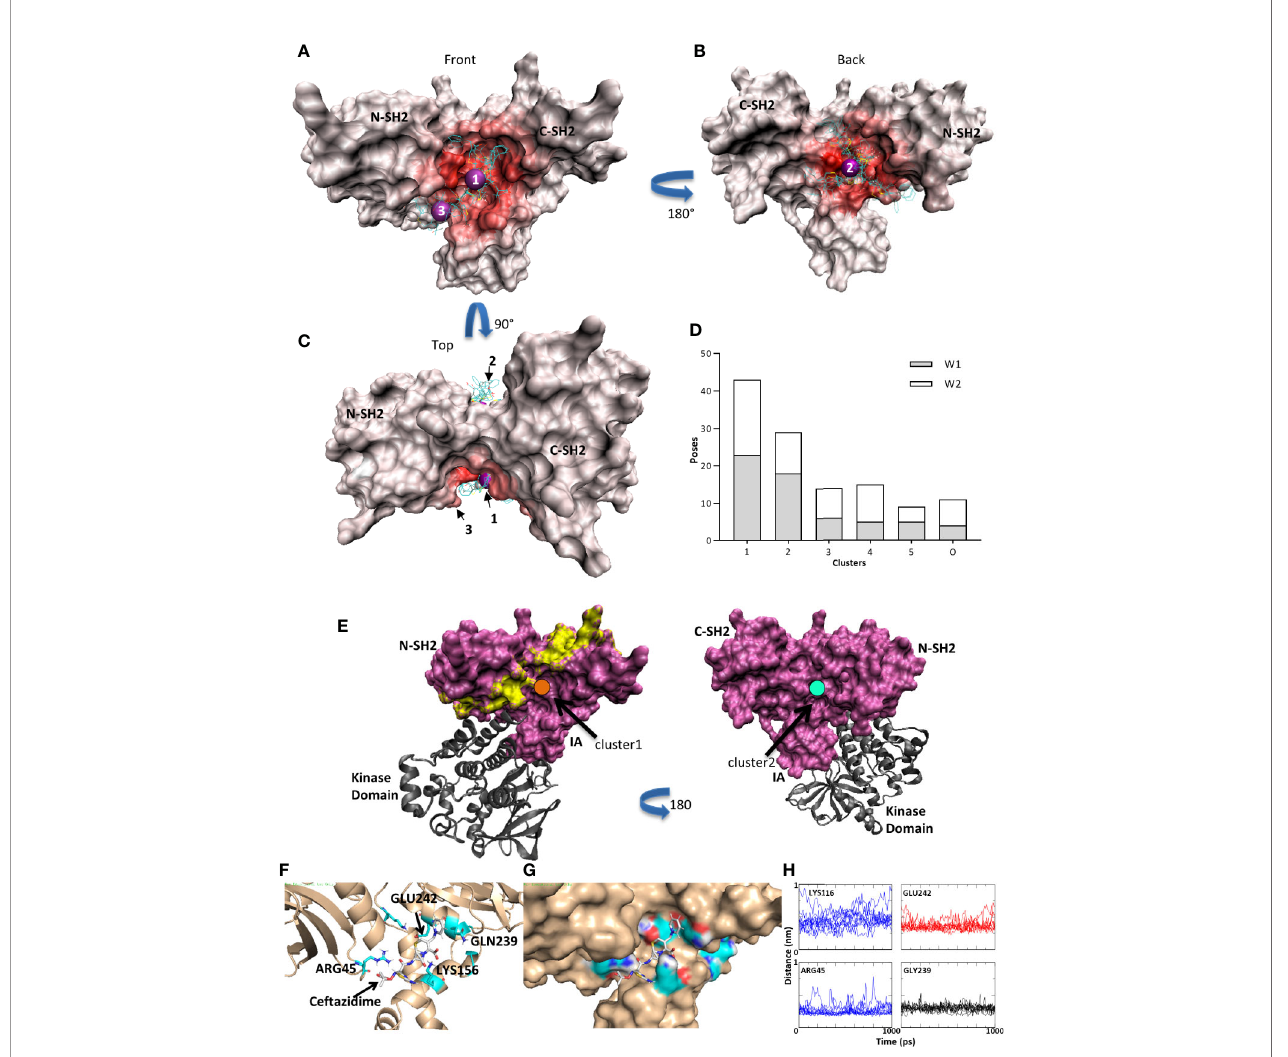
FIGURE 5 | Syk kinase/ceftazidime binding. (A) Red heat map indicates the number of contacts between Syk and the docked poses. A few typical poses are shown for illustration purposes. Purple spheres are the centroid of clusters 1 and 3 in the front view. (B) Heat map of contacts on the rear view and purple sphere at the centroid of cluster 2. (C) Rotation of 90 degrees to the top view. (D) Histogram of clusters. Clusters 1 and 2 have the largest populations and are characterized by fi tting into the pocket at the tandem SH2 domain and interdomain interface on the front and back. Window 1 (W1) is a large unbiased search window and window 2 (W2) is a smaller, focused window to increase sampling in the pockets (see Supplemental Figure S7 ). (E) Cluster 1 (orange; left panel) is adjacent to the residues that would interact when a pITAM peptide (yellow surface) is bound but may allow for co-binding. Cluster 2 (cyan; right panel) is on the back face and thus interacts with neither pITAM binding areas nor Syk catalytic domain binding interfaces. (F) Molecular dynamics simulations in GROMACS. A typical trajectory frame during MD simulations with residues GLN239 and LYS156 making stabilizing interactions. ARG45 and GLU242 also contribute. (G) The same trajectory frame as shown in (F) illustrating one possible binding mode in the groove between the N-term SH2 domain and the IA domain. (H) Distances between ceftazidime and LYS116, GLU242, ARG45, and GLN239 during one representative 10 ns trajectory (1 ns is